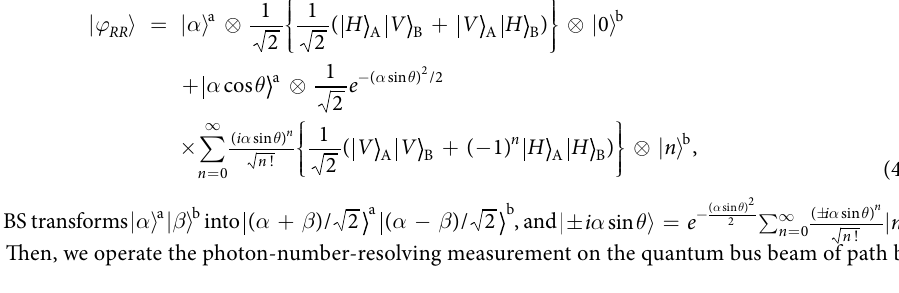
, as shown in 33,78–80 , we can acquire | r 0 ( ω )| = | r h ( ω )| ≈ 1, c X and vacuum noise ˆ N 20,33–40 . Finally, when we take the in